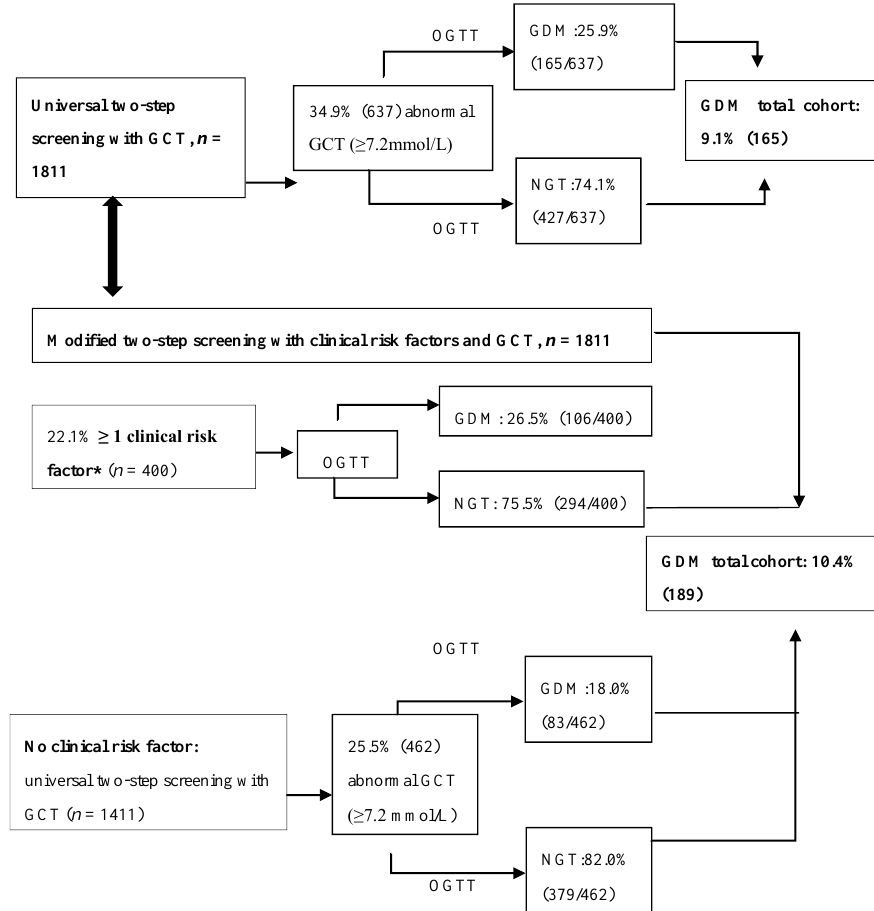
Figure 2. Universal two-step screening strategy with GCT ≥ 7.2 mmol/L, compared to the modified two-step screening strategy with GCT and clinical risk factors. GCT: 50 g glucose challenge test; OGTT: 75 g 2-h oral glucose tolerance test; GDM: gestational diabetes mellitus; NGT: normal glucose tolerance; * clinical risk factors: BMI ≥ 30 kg/m²; an ethnic minority background or a history of gestational diabetes mellitus.